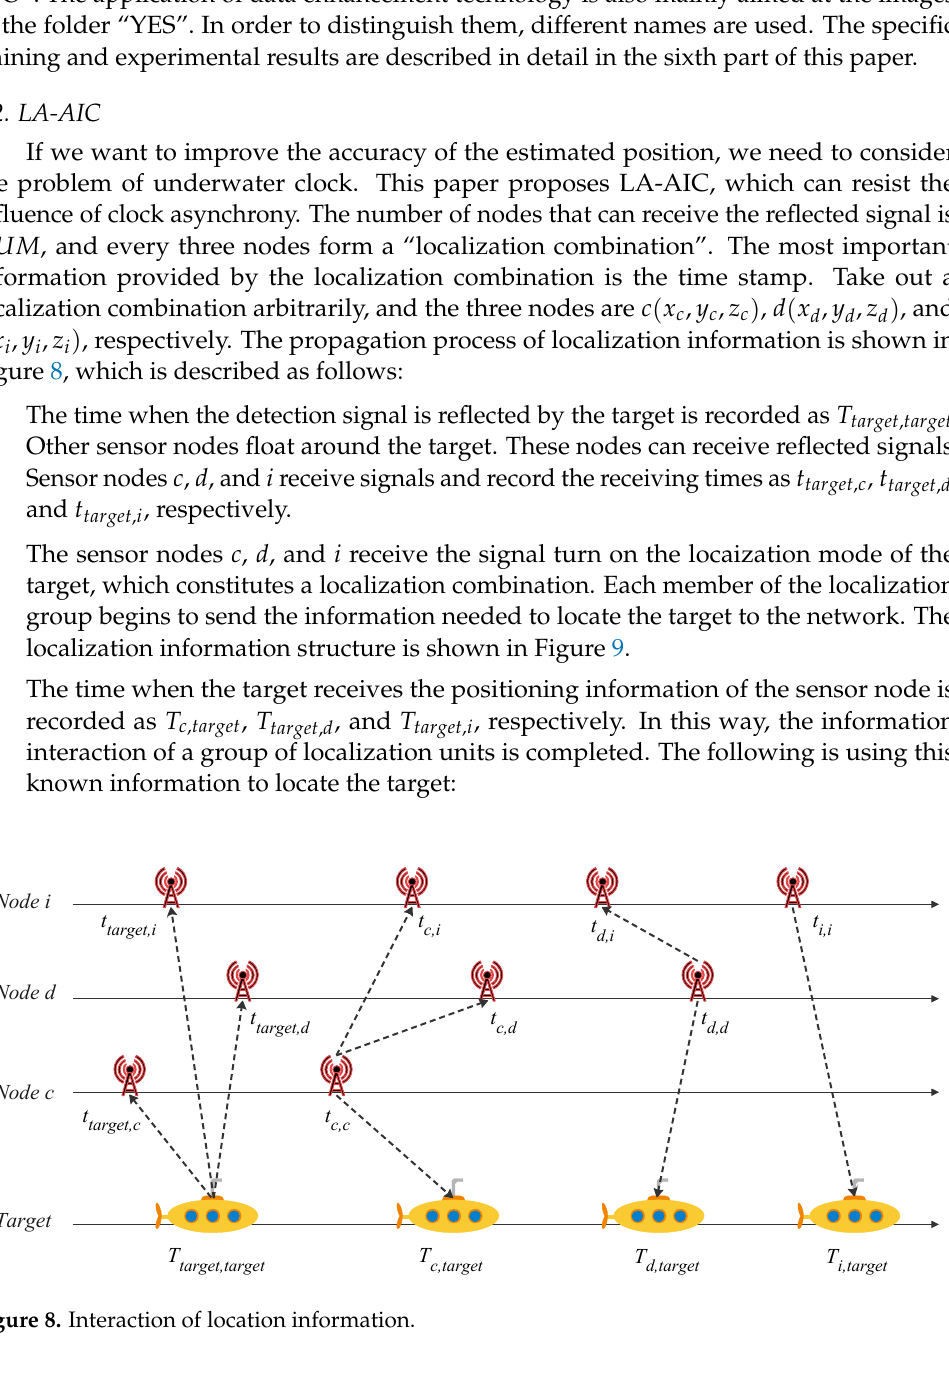
Figure 9. Location information structure